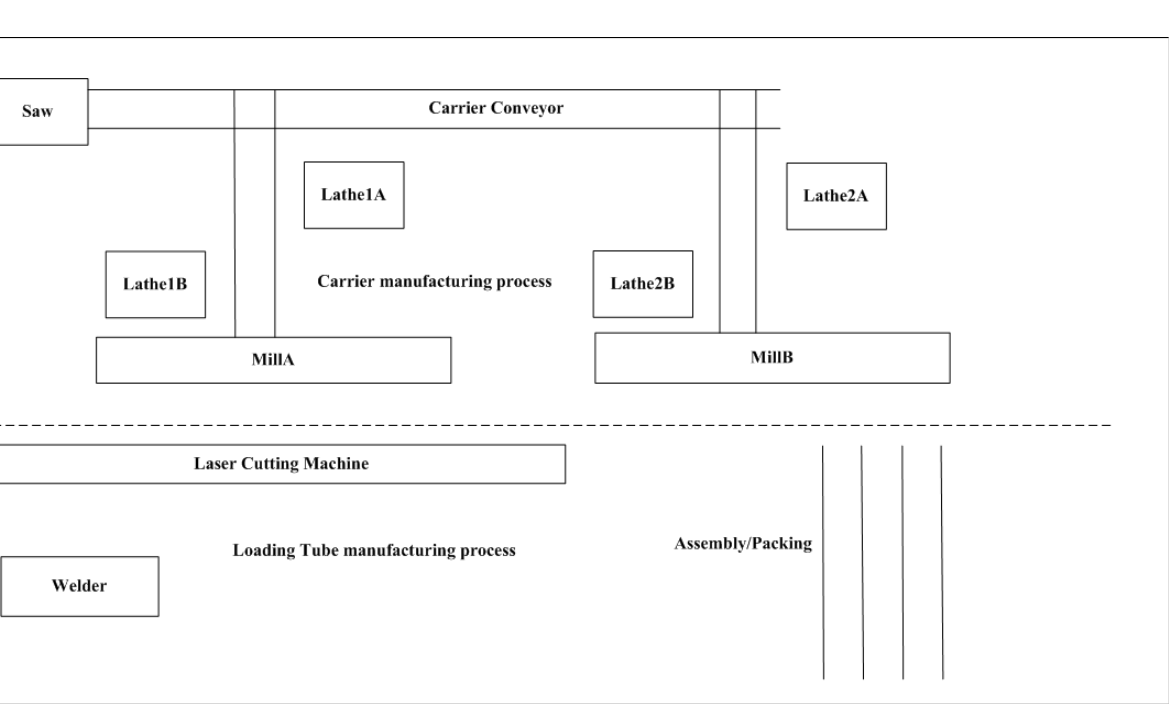
Figure 1. Current facility layout